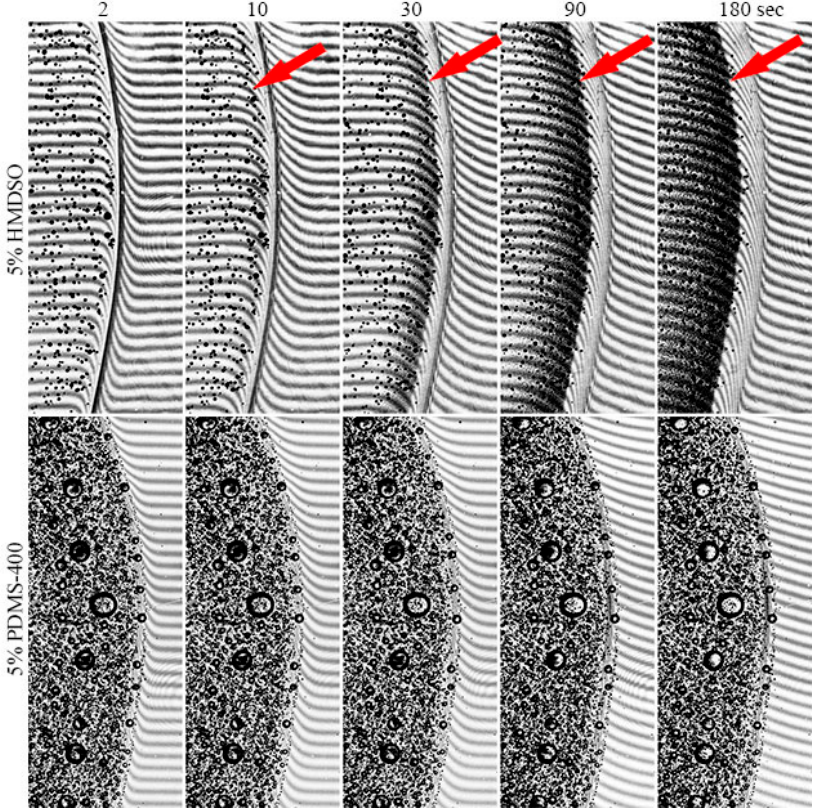
inclusion, both with variable and uniform distributions over the cross section, and—consequently— over the volume of the finished product. Such fibers were spun on a wet spinning stand shown in Figure 13. The evolution of interferograms upon the contact of PAN solutions containing 5% of HMDSO and PDMS-400 (left) with a coagulant (85% DMSO solution in water) (right) in time.